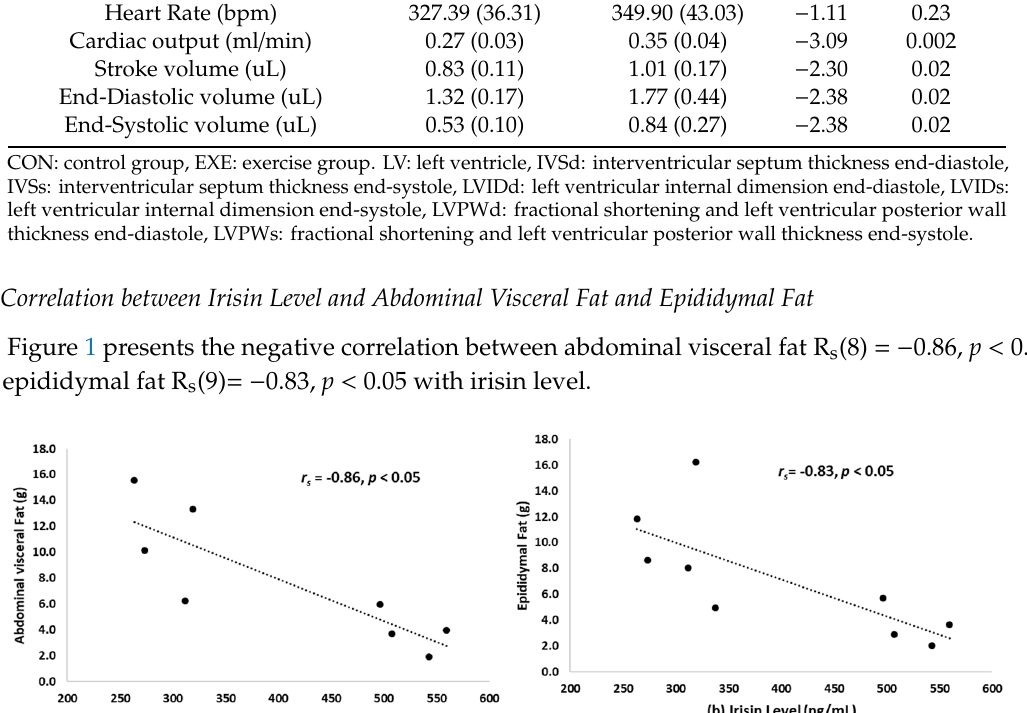
Table 4. Description of the echocardiogram variables between the control and exercise group.